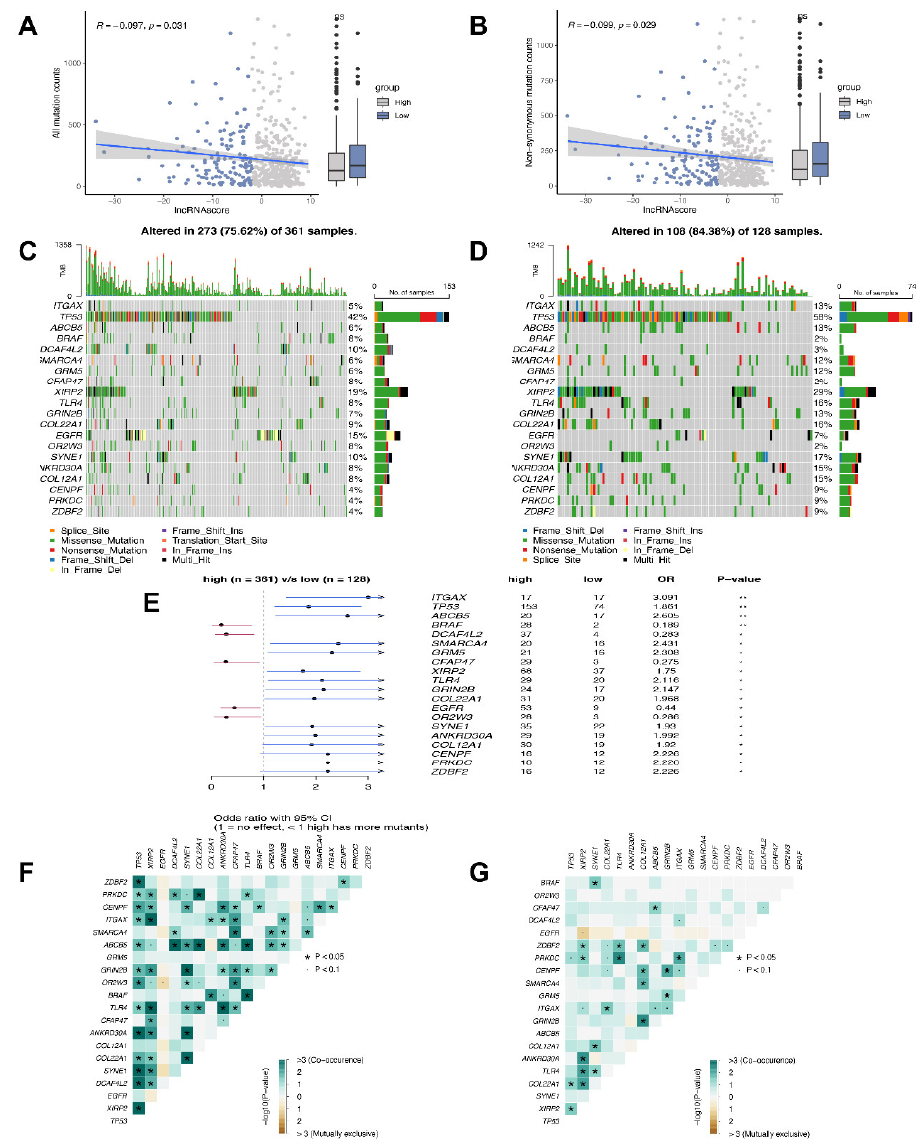
Figure 6. LncRNA score was related to tumor mutation status. Association between ( A ) all mutation counts, ( B ) non-synonymous mutation counts and the lncRNA score in the high and low lncRNA score groups; Visual summary showing common genetic alterations in the ( C ) high and ( D ) low lncRNA score groups; ( E ) Forest plot of gene mutations in the patients; Interaction effect of genes mutating differentially in patients in the ( F ) high and ( G ) low lncRNA score groups. * p < 0.05, ** p <